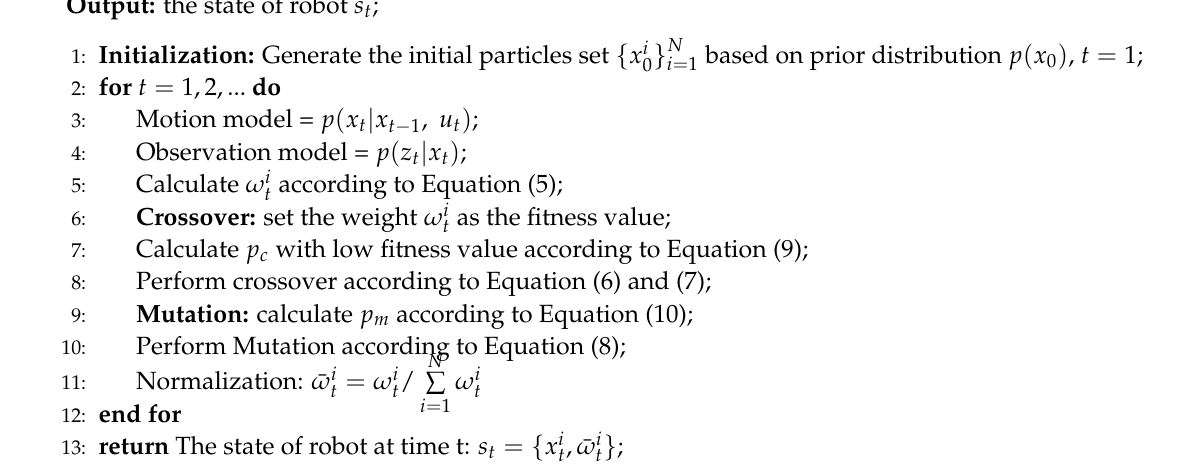
Algorithm 1 Image-based Monte Carlo localization